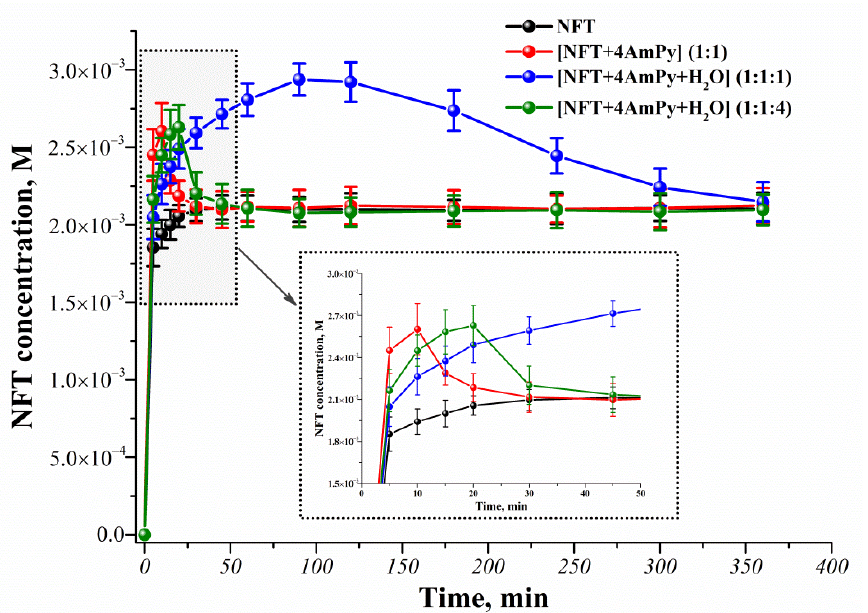
Figure 7. Dissolution profiles of the anhydrous NFT and its multicomponent crystals in pH 7.4 buffer solution at 37 °C. Insert: enlarged illustration of the data within the 0 to 50 min time frame.